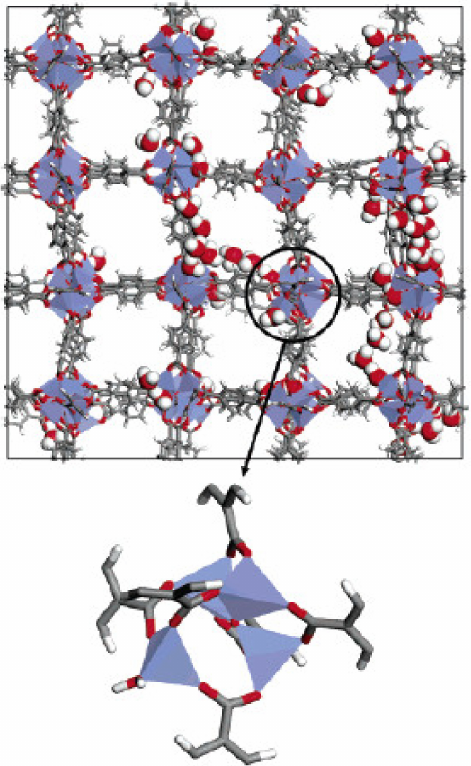
Figure 6. Disruption of MOF-5 in water (Ref.